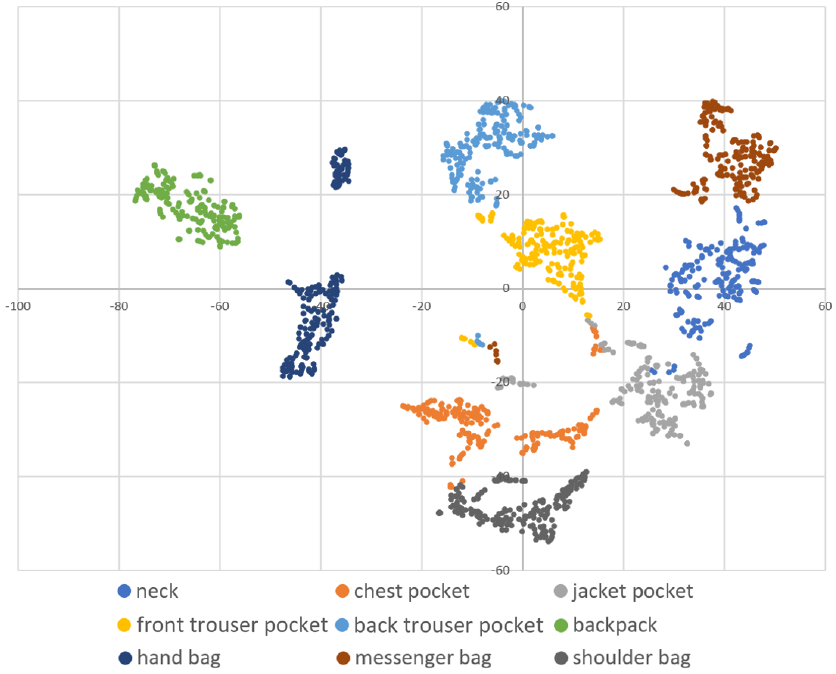
Figure 4. A two-dimensional visualization of the data of one subject using t-SNE in dataset B.